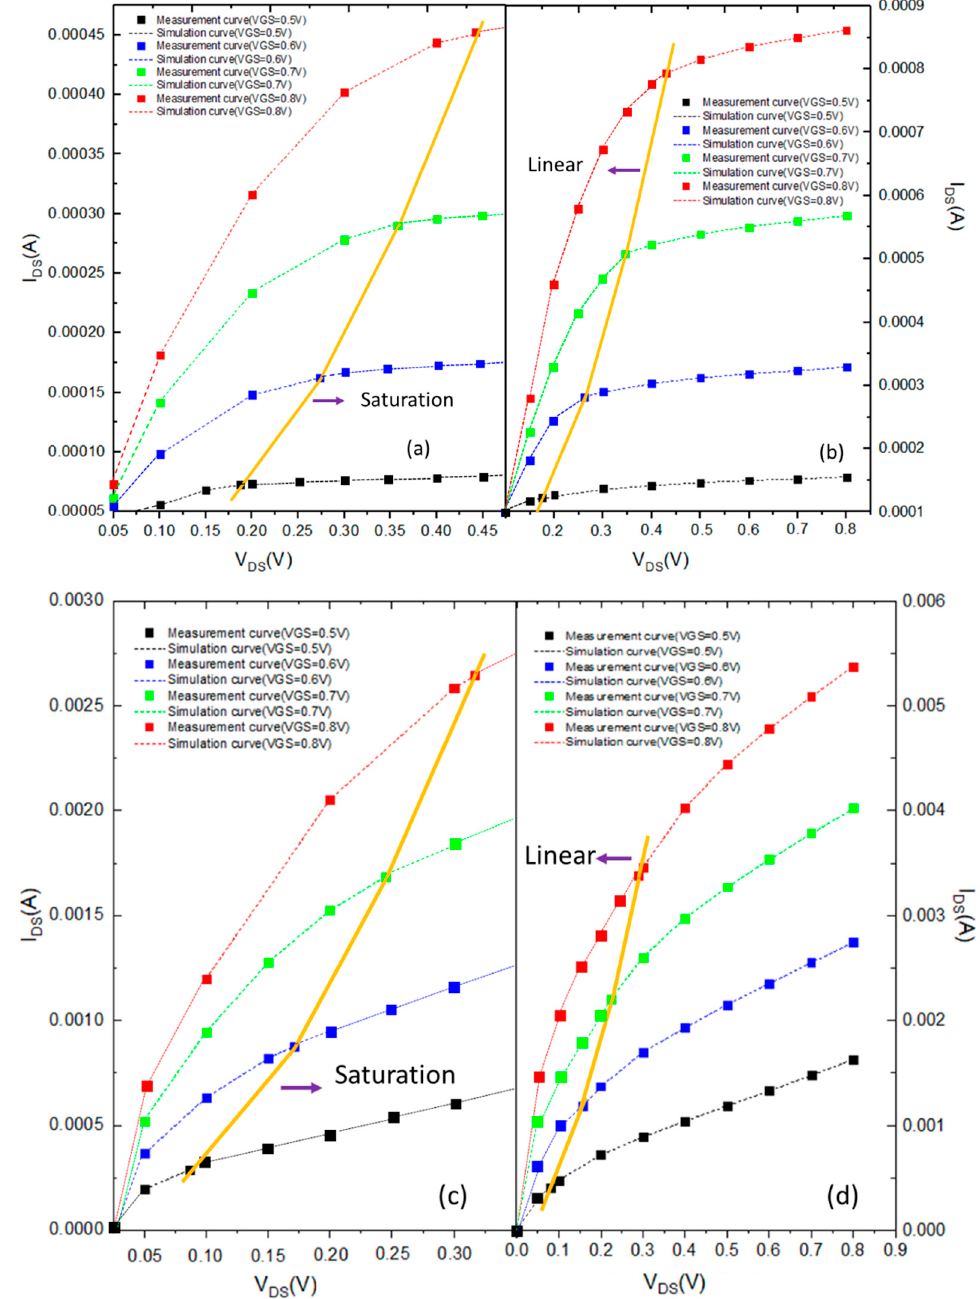
Figure 7. I DS vs. V DS curves for long-channel devices: ( a ) at L mask = 1 µ m in section X = a , and ( b ) at L mask = 500 nm in section X = b ; for short-channel devices: ( c ) at L mask = 50 nm in section X = c , and ( d ) at L mask = 33 nm in section X = d . The yellow lines mean the pinch-off boundary at V Dsat = V GS − V T , where V T is the threshold voltage.